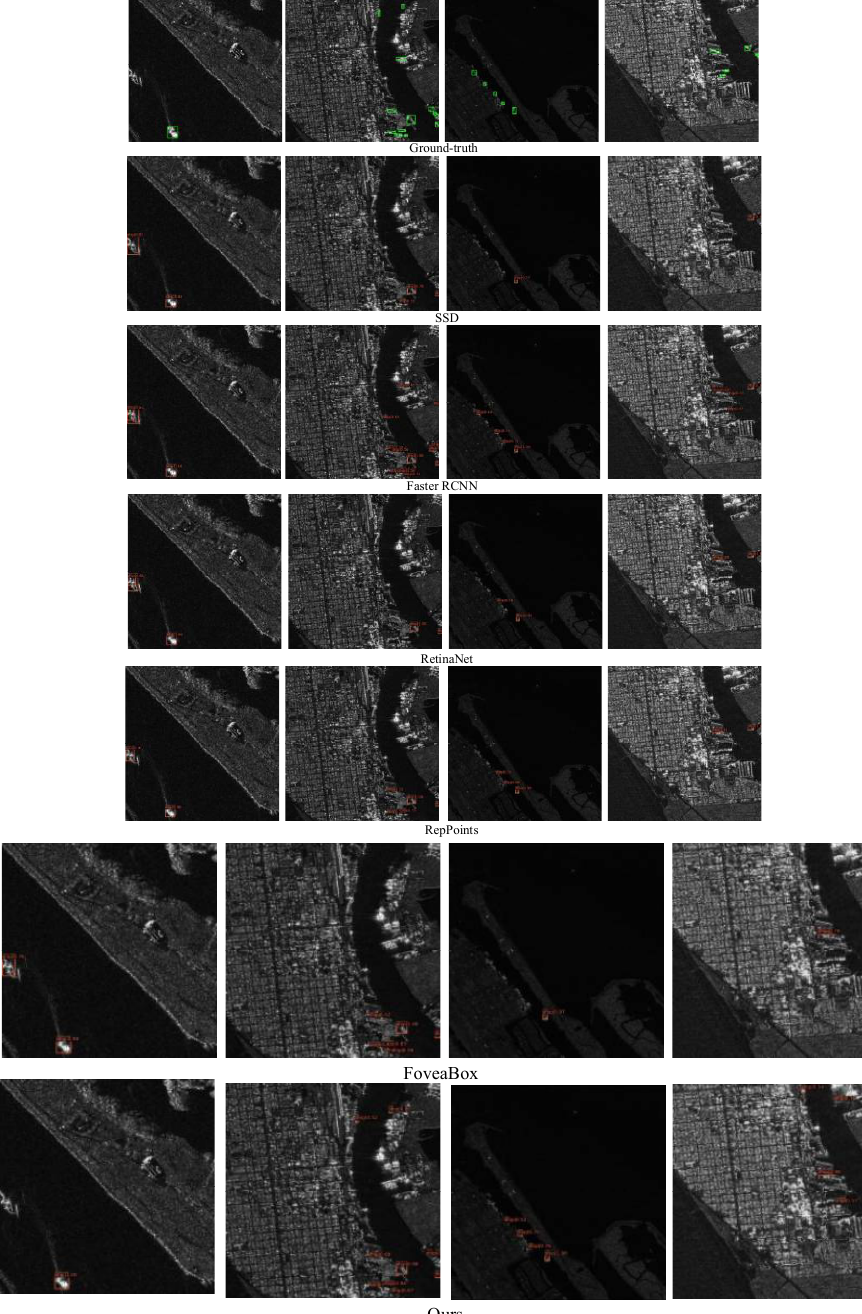
Figure 8. Comparison of the results of different methods on HRSID. The green rectangles indicate the ground-truth, and the red rectangles indicate the detection